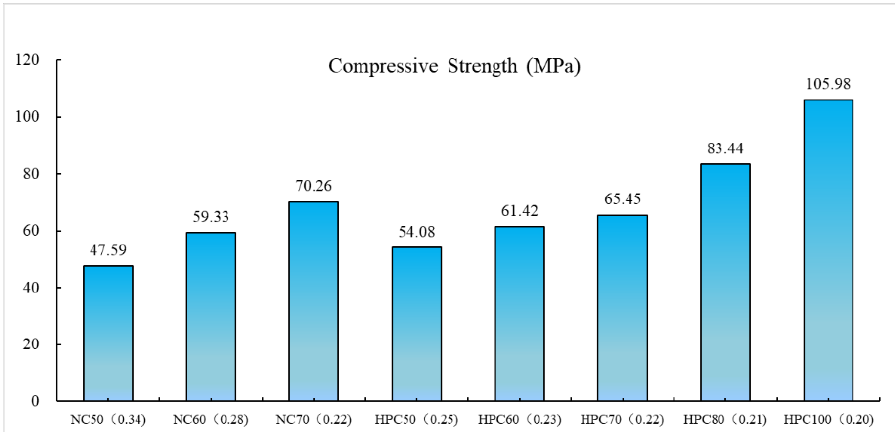
Figure 3. Compressive strength of the Group Ⅰ specimens.